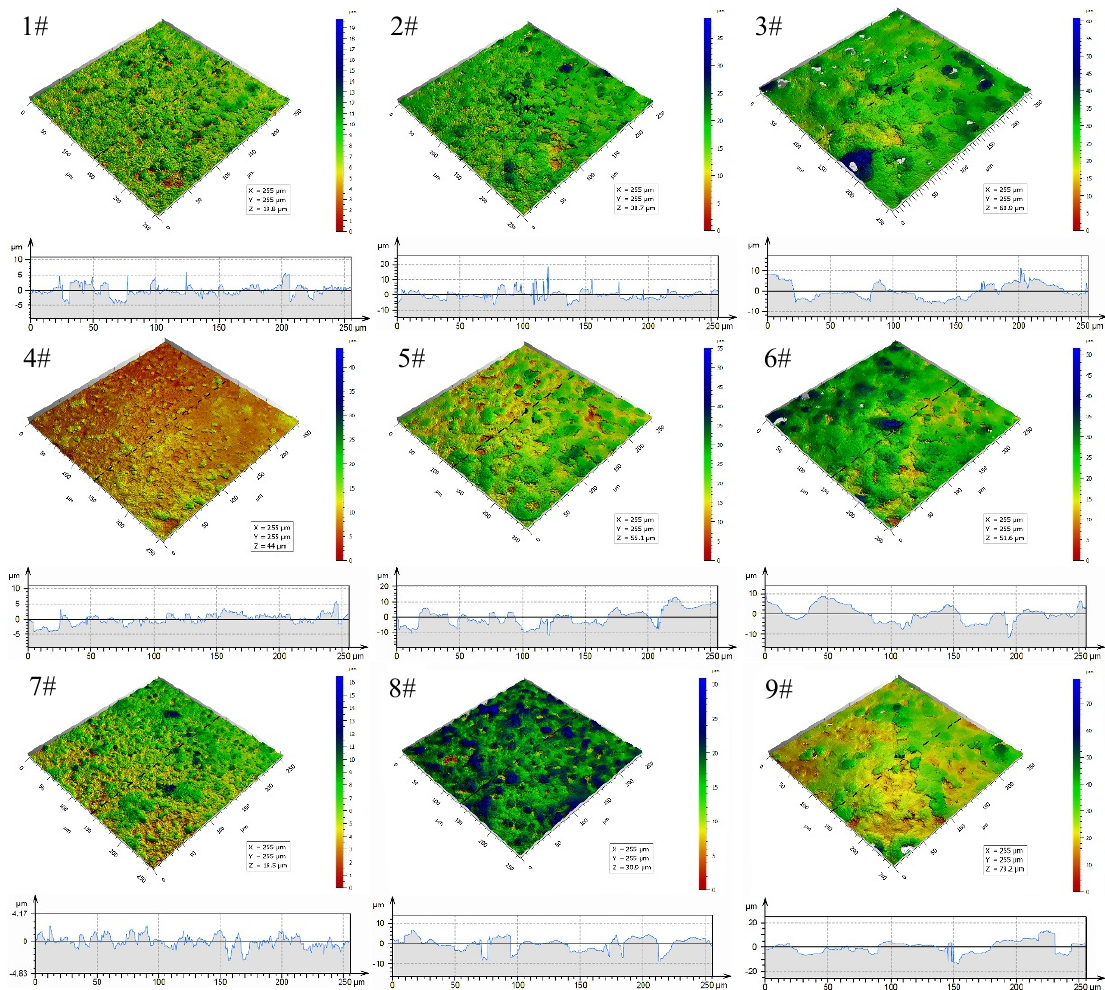
Figure 3. 3D surface morphologies and depth profiles of black MAO coating samples 1 # − 9 # .